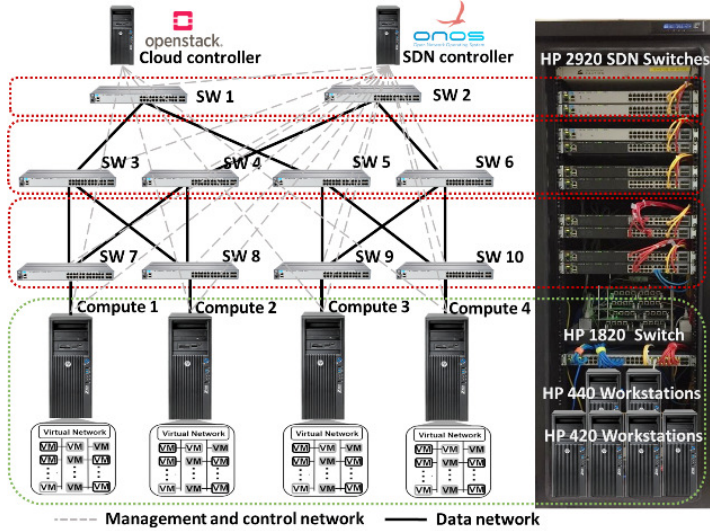
Figure 12. Experimental setup of SDDC testbed.